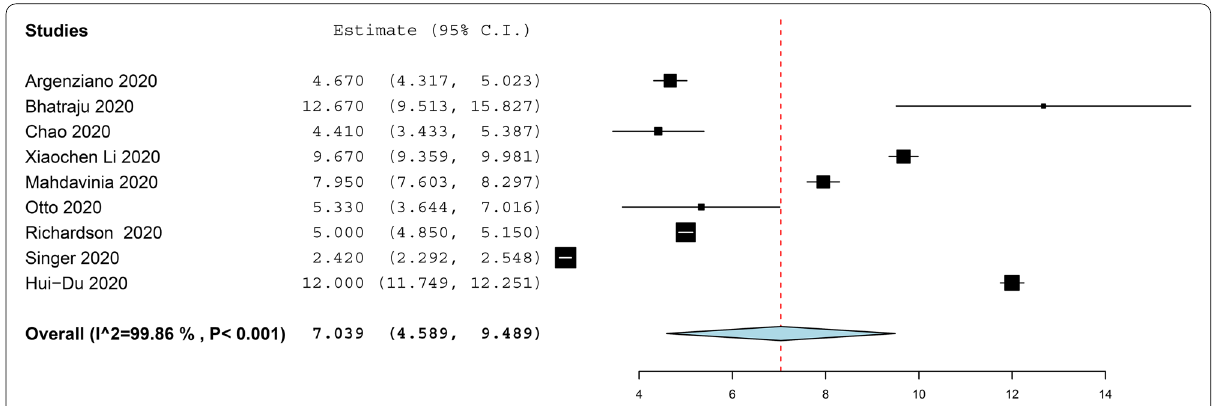
Fig. 5 The hospitalization time in COVID‑19 patients